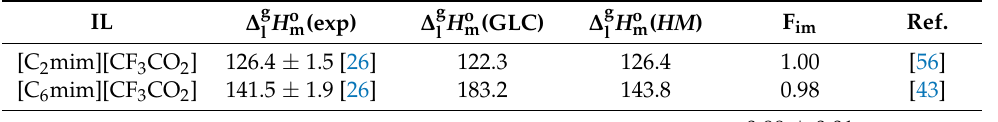
Table 2. [C n mim][CF 3 CO 2 ] series: comparison of ∆ g Equations (5) and (6) with experimental results from conventional methods a .